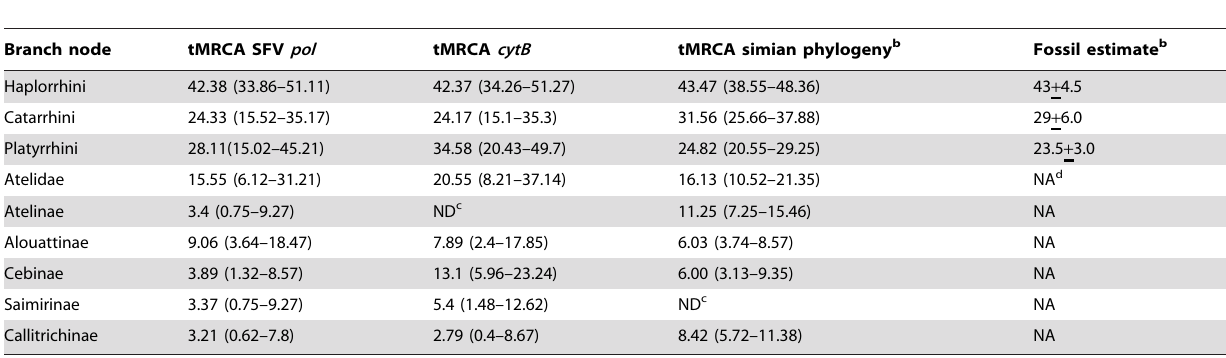
Table 4. Time to most recent common ancestor (tMRCA) mean estimates for Haplorrhini and simian foamy virus (SFV) polymerase ( pol) and simian cytochrome B ( cytB ) sequences a